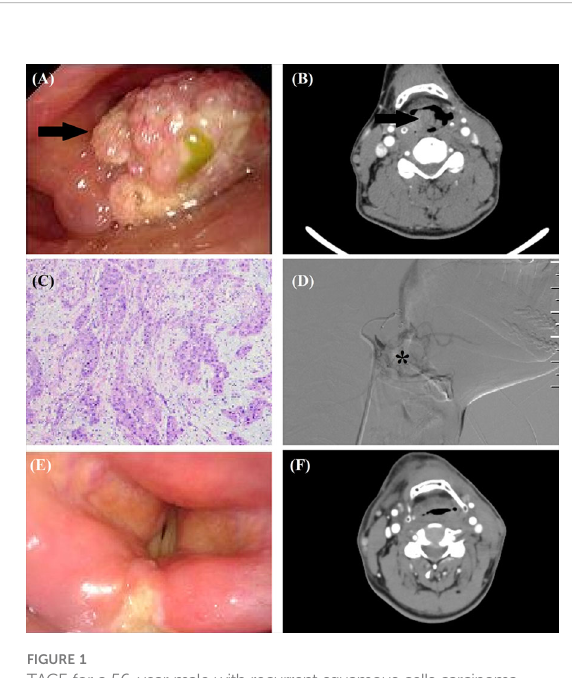
FIGURE 1 TACE for a 56-year male with recurrent squamous cells carcinoma after tongue cancer resection. (A, B) A recurrent tumor (arrow) was shown by laryngoscopy and computed tomography. (C) The tumor was histopathologically diagnosed as squamous cells carcinoma. (D) Tumor staining (*) was shown by angiography. (E, F) Laryngoscopy and computed tomography con fi rmed that the tumor disappeared 7 months after